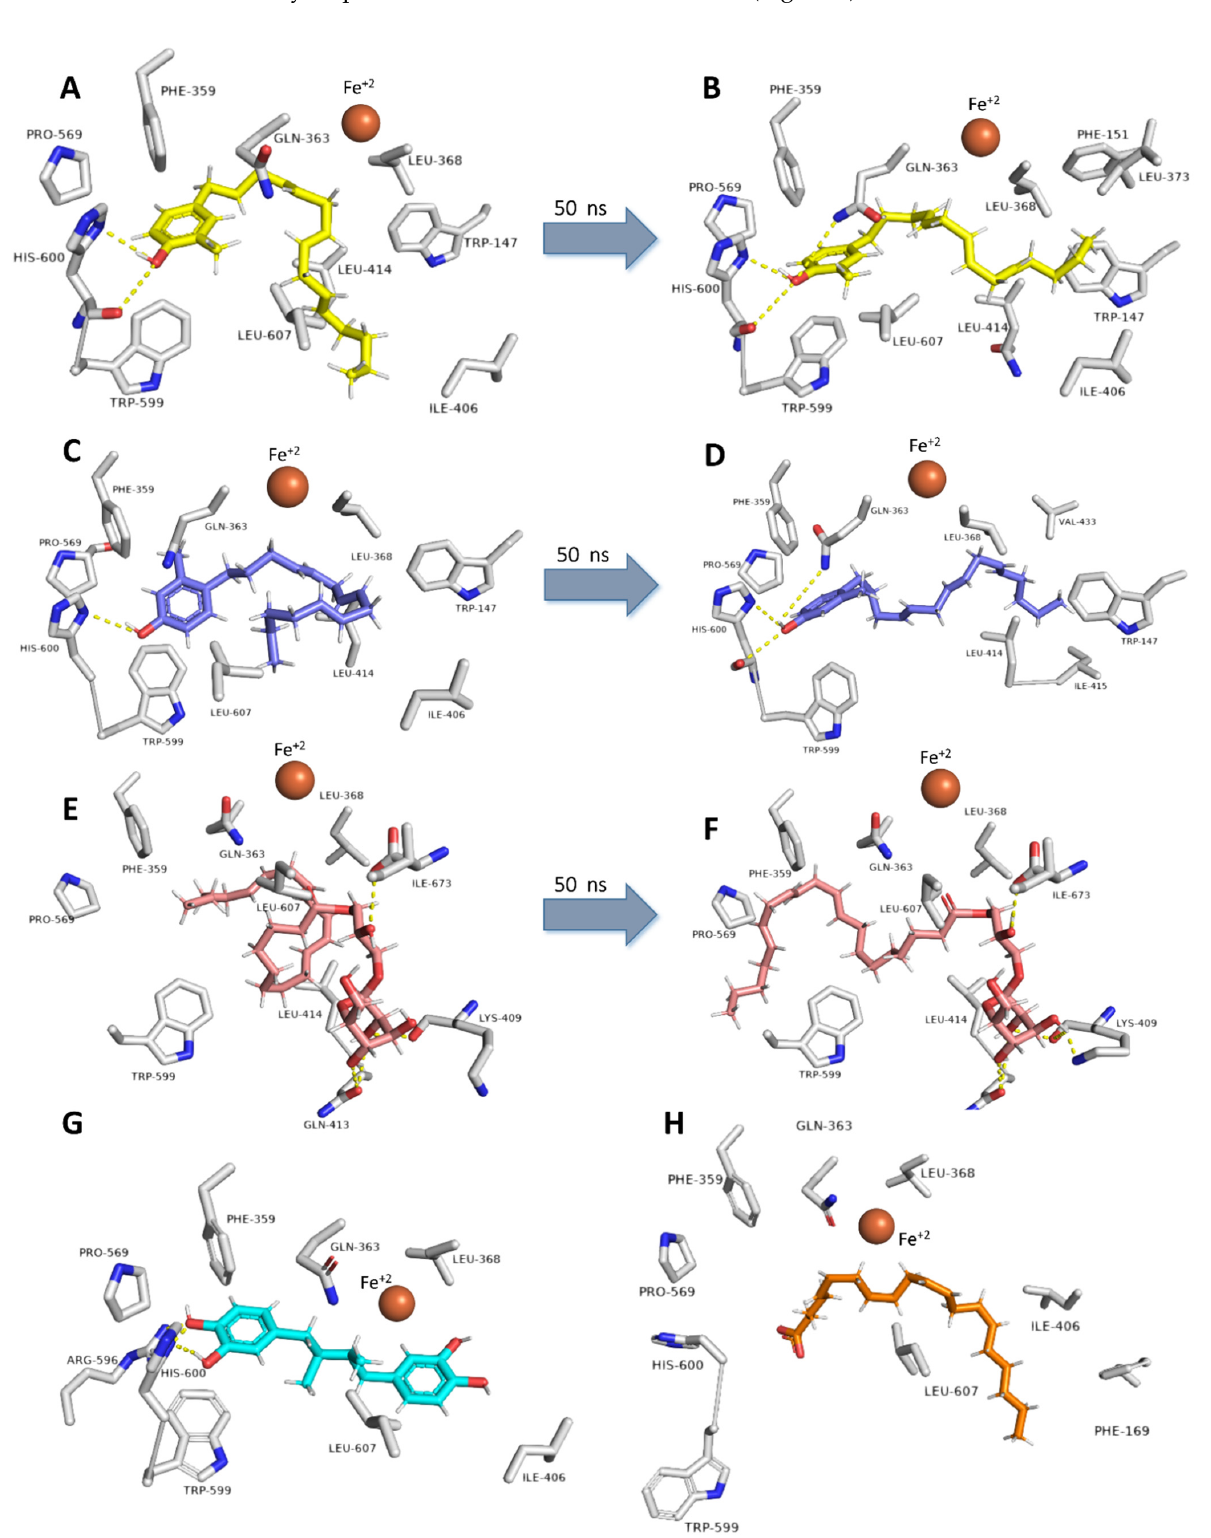
Figure 5. Binding modes of compounds 12 , 13 , and 19 inside 5-LOX’s active site. ( A , C , E ) Their binding modes upon docking. ( B , D , F ) Their binding modes over 50 ns MDS. ( G , H ) Binding modes of the co-crystalized ligands AA and NDGA.